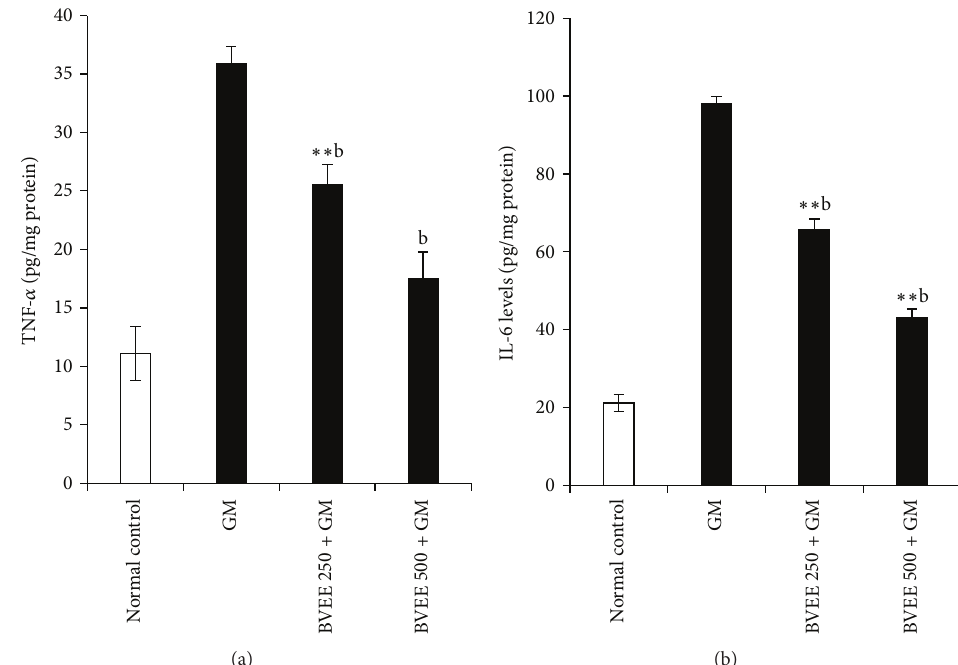
Figure 2: Effect of BVEE on gentamicin-induced changes in proinflammatory cytokines in kidney tissues of rats. (a) Tumor necrosis factor- 𝛼 (TNF- 𝛼 ) and (b) interleukin-6 (IL-6). The results are presented as the mean ± SEM of six animals per group. “ ∗ , ∗∗ ” ∗∗∗ denotes significant differences from the control group ( 𝑃 < 0.05 , 𝑃 < 0.01 , and 𝑃 < 0.001 ); “ a , b , c ” denote significant differences from the GM group ( 𝑃 < 0.05 , 𝑃 < 0.01 , and 𝑃 < 0.001